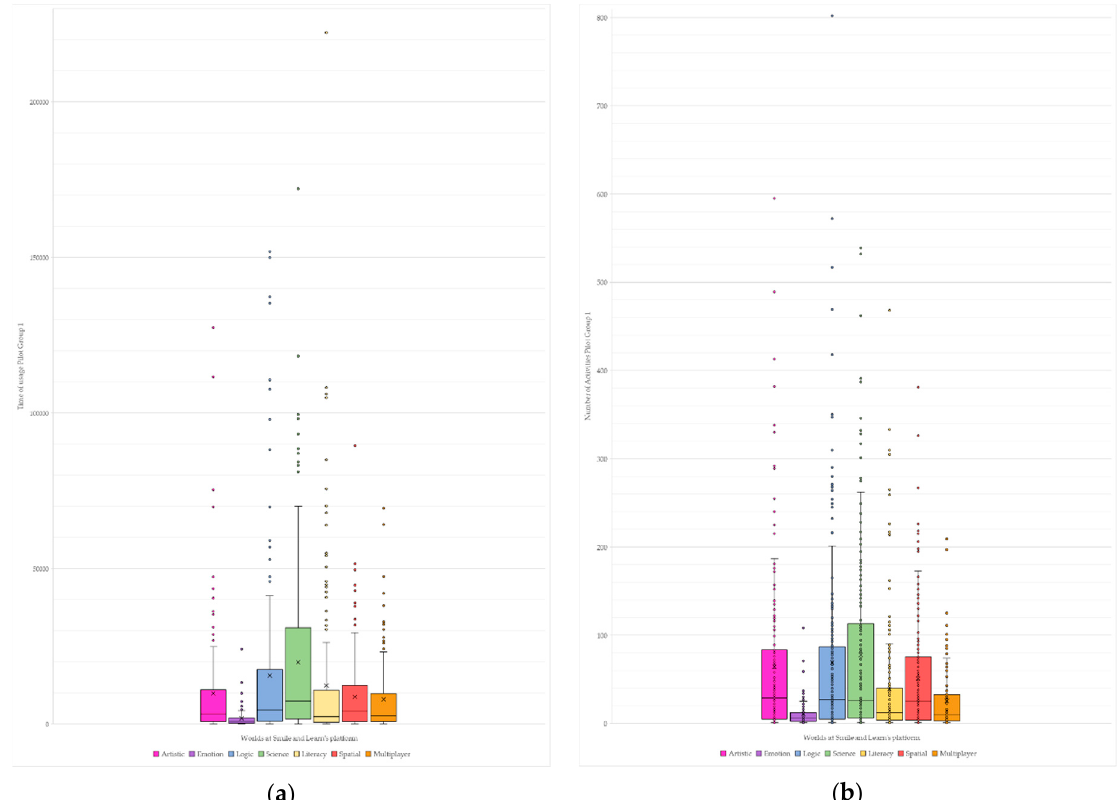
Figure 3. Pilot Group 1’s use of worlds (Arts, Emotion, Logic, Science, Literacy, Spatial, Multiplayer) at Smile and Learn’s platform. ( a ) General time of usage (seconds) with the platform for Pilot Group 1; ( b ) General number of activities played by Pilot Group 1 with the platform.